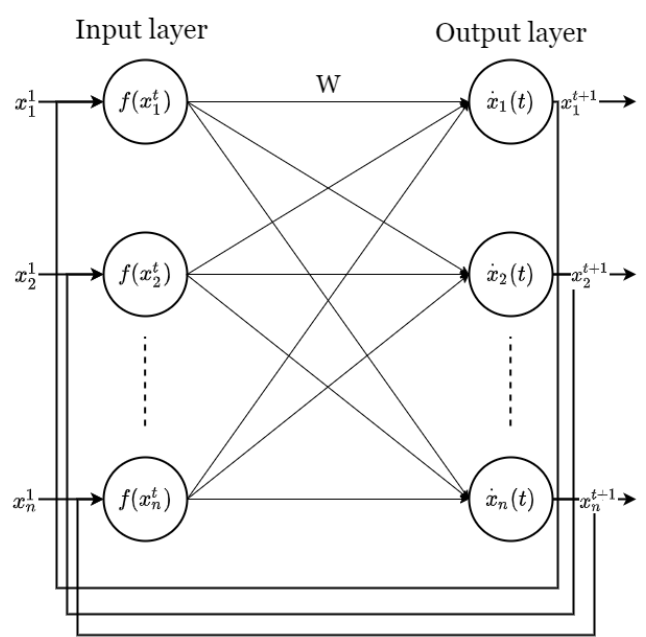
Figure 7. The structure of LAHN resembles the traditional Hopfield network. The input x ( t ) denotes the neuron state in time step t , the output of the network ˙ x ( t ) is the momentum of the current state, we can get the next state (i.e., the input of the network in time step ( t + 1) by Equation (10), and the stable state could be achieved if we evolve the network